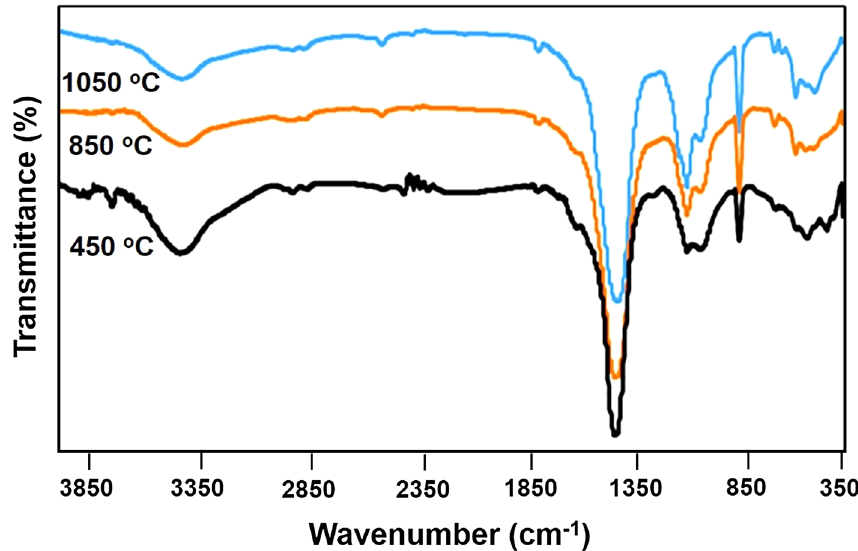
Figure 4. FT-IR spectra of RO WA prepared at different combustion temperatures.